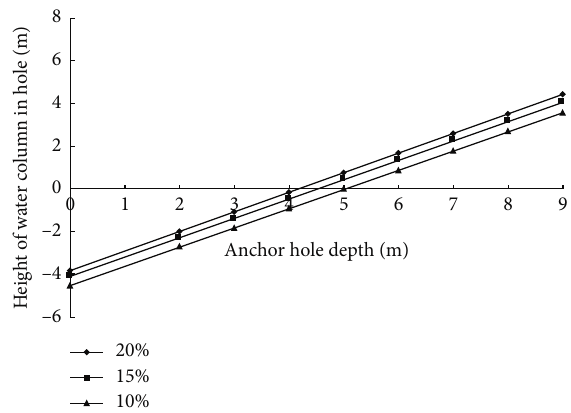
Figure 3: Relationship of floor anchoring hole depth and flush fluid height in the hole.